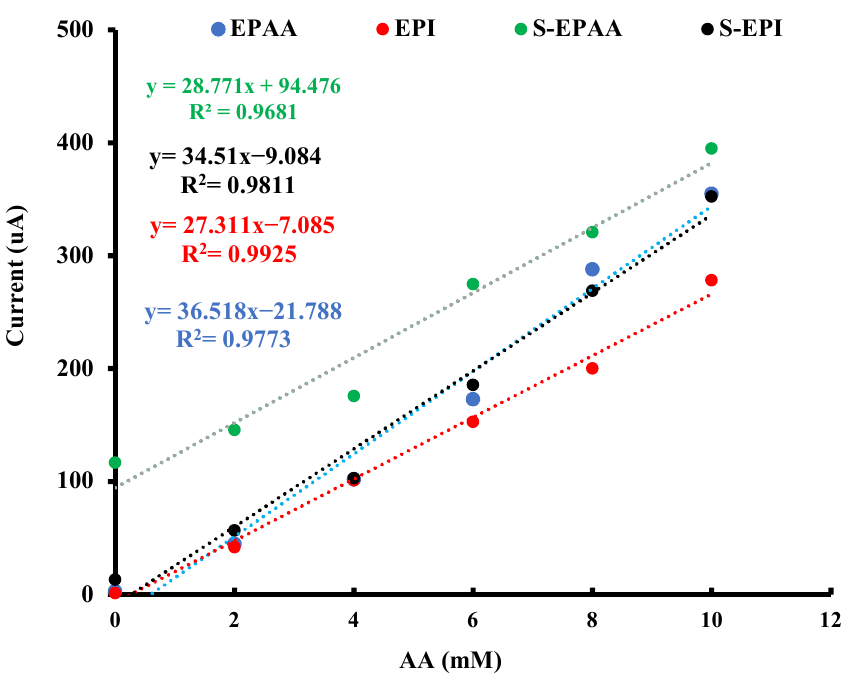
Figure 4. Linear calibration curves of CPE-modified EPAA, EPI, S-EPAA and S-EPI electrodes in PBS (pH 7) with different AA concentrations.